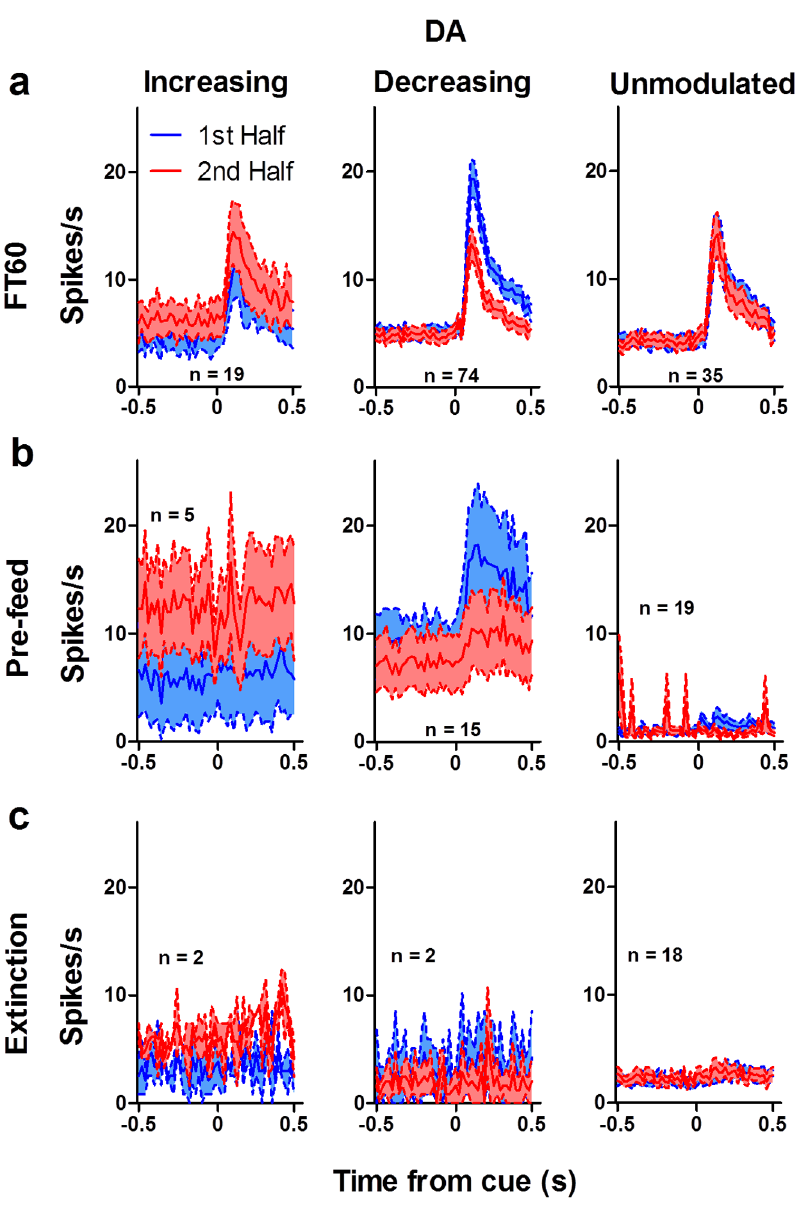
Figure 11. Summary of phasic response in dopamine neurons. To compare the magnitude of the satiety effect to the magnitude of the mean response, we plotted the responses of all dopamine neurons showing a cue-elicited phasic burst. ( a ) The phasic response to the cue of increasing DA neurons ( n =19) was higher for the second half of FT60 sessions than it was for the first half. Decreasing DA neurons ( n =74) showed the opposite pattern. The phasic response of unmodulated neurons ( n =35) did not change over time. Modulation of the phasic response was reduced by pre- feeding ( b ; n =5 increasing, 15 decreasing, 19 unmodulated) and eliminated during extinction ( c ; n =2 increasing, 2 decreasing, 18 unmodulated). The phasic response of increasing neurons was nearly abolished following pre-feeding and during extinction, and the phasic response of decreasing neurons was abolished during extinction.